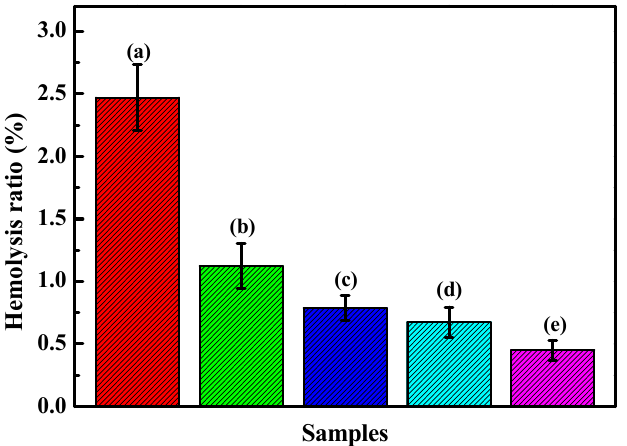
Figure 11. Hemolysis ratio results of the uncoated 316L SS and HfC coatings deposited at different bias voltages: ( a ) 316L SS, ( b ) 0 V, ( c ) − 100 V, ( d ) − 150 V, and ( e ) − 200 V.